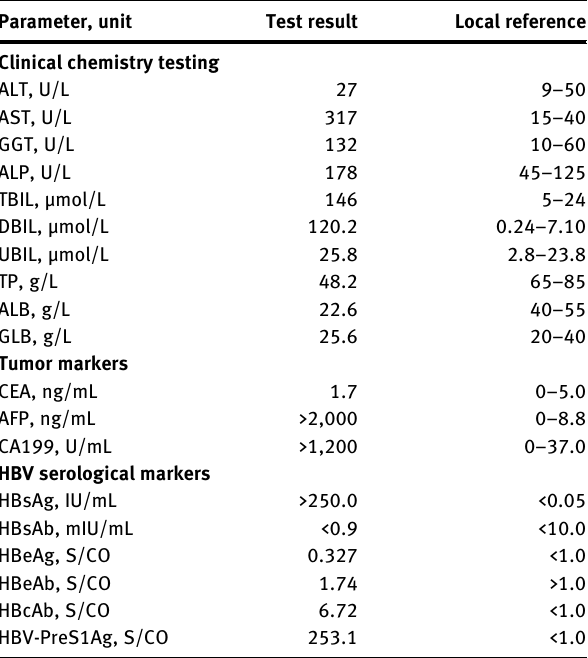
Table  : Related laboratory testing parameters on February  th,  . Parameter,